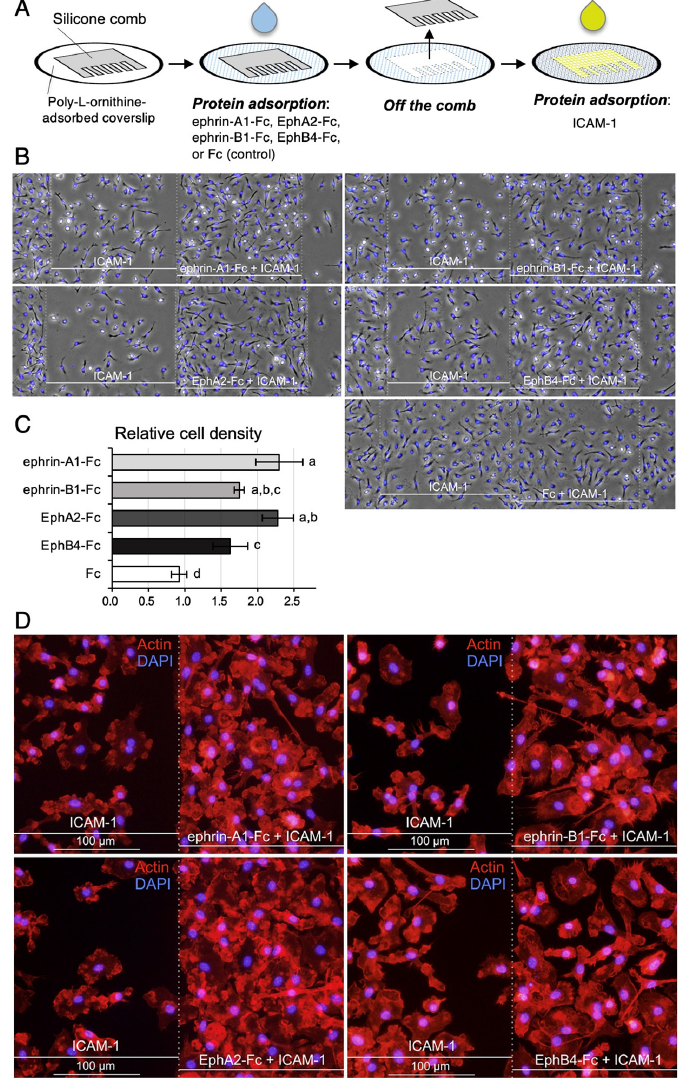
Figure 10. Liver Mø preferentially occupy the ephrin or Eph protein plus ICAM-1-adsorbed surface that mimics that of LSECs. ( A ) Schematic illustration of the ephrin or Eph protein adsorption procedure in stripes. The Fc chimera (test) or Fc protein (control) was adsorbed onto the coverslip surface, to which a comb-shaped silicon mask was applied. After washing and removing the mask, ICAM-1 was adsorbed onto the surface. The coverslips were placed in 6 cm culture dishes with culture medium. Liver Mø were plated and cultured for 16 h. Then, cells on the coverslips were fixed with Formalin/PBS and incubated with a mixture of Alexa 568-labeled phalloidin and DAPI. ( B )Typical phase-contrast micrographs merged with the fluorescence images of DAPI staining (blue, nucleus) showing liver Mø cultured on the coverslip surface, wherein regions adsorbed with the indicated ephrin/Eph protein appeared as stripes. In the control Fc stripes, the liver Mø did not form stripes with different cell densities. ( C ) Quantified cell densities in regions adsorbed with ephrin/Eph or Fc protein plus ICAM-1 relative to those in adjacent control regions absorbed only with ICAM-1. Data from three independent experiments are shown as the mean ± SD. Values with different superscripts indicate significant differences among ephrin/Eph/Fc stripes ( p < 0.05). ( D ) Typical fluorescence images of F-actin staining (orange-red) merged with those of DAPI staining showing the boundary between regions adsorbed with the indicated ephrin/Eph plus ICAM-1 and those with only ICAM-1 protein. Blank zones without cells appeared in the control region adjacent to the ephrin/Eph protein-adsorbed test region.